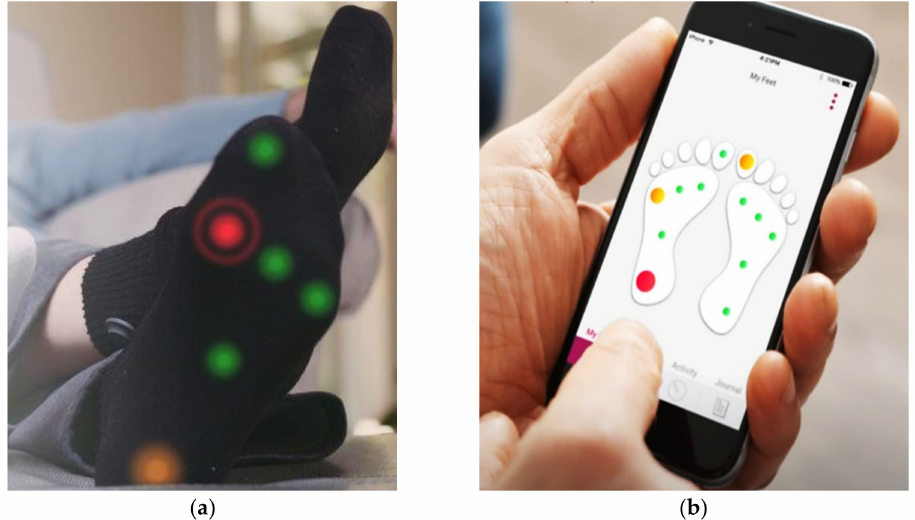
Figure 7. Smart socks developed by Siren with a detection system that can help to detect the first signs of foot ulcers: sensitive socks ( a ) and smartphone app ( b ), Adapted from [41]. Bonbouton Co. patented a smart insole to monitor the foot health of diabetic patients, detecting the skin temperature, pressure, and other data using a graphene-based sensor